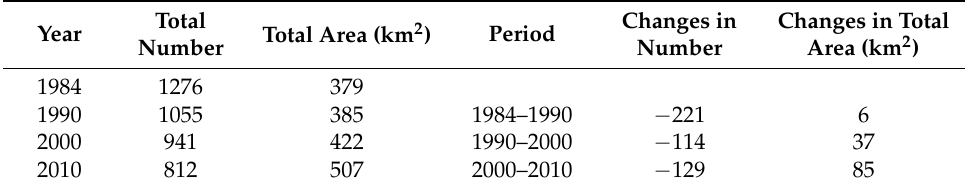
Table 3. The numbers of villages and total areas of developed land in different time slices and their changes.